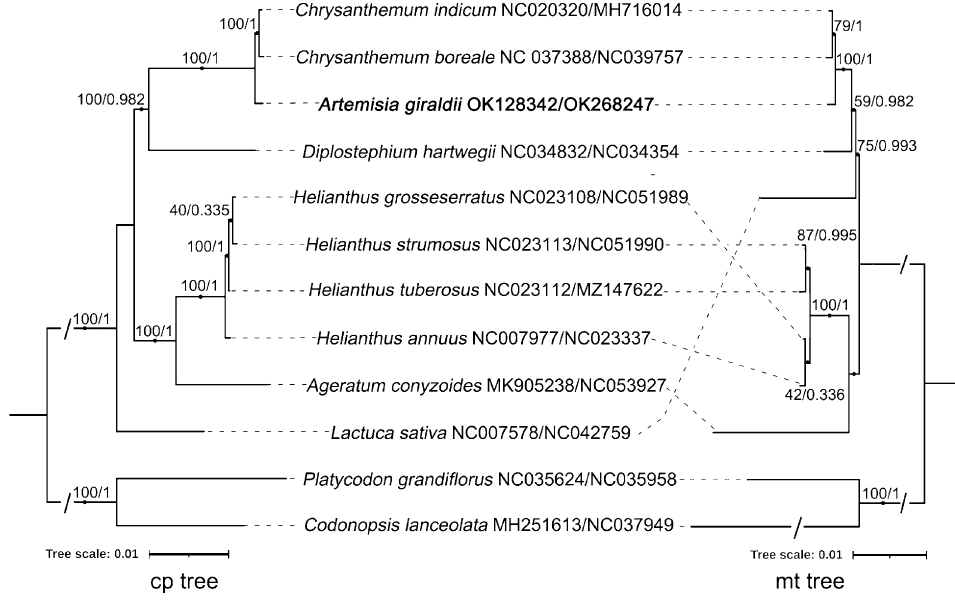
Figure 5. The phylogenetic relationships among A. giraldii and nine Asteraceae species using the maximum likelihood (ML) and Bayesian Inference (BI) methods. The sequence obtained from this study is highlighted in bold. The left is the phylogenetic tree constructed based on the coding sequences of 67 PCGs from the plastome. In contrast, on the right is the phylogenetic tree based on the coding sequences of 29 PCGs from the mitogenome. The numbers indicate the bootstrap values for the ML tree and Bayesian inference (BI) posterior probabilities for the BI tree, separated with a slash. The GenBank accession numbers of the plastomes and mitogenomes are shown after the Latin name of the related species, respectively. The length of the branch corresponds to the frequency of base substitutions. The phylogenetic trees constructed by the maximum likelihood (ML) and Bayesian Inference (BI) methods were visualized by iTOL (v5) (https:// itol. embl.